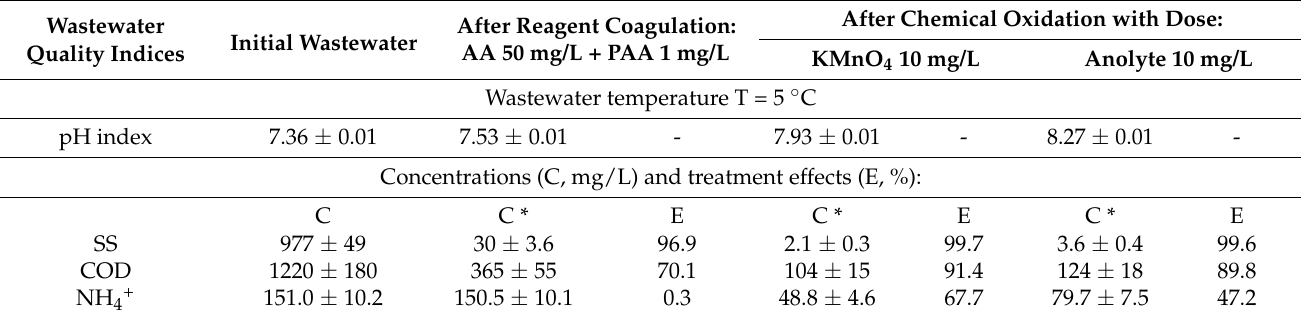
Table 4. The initial wastewater parameters and the course and results of the laboratory oxidation studies (2020). Wastewater Quality